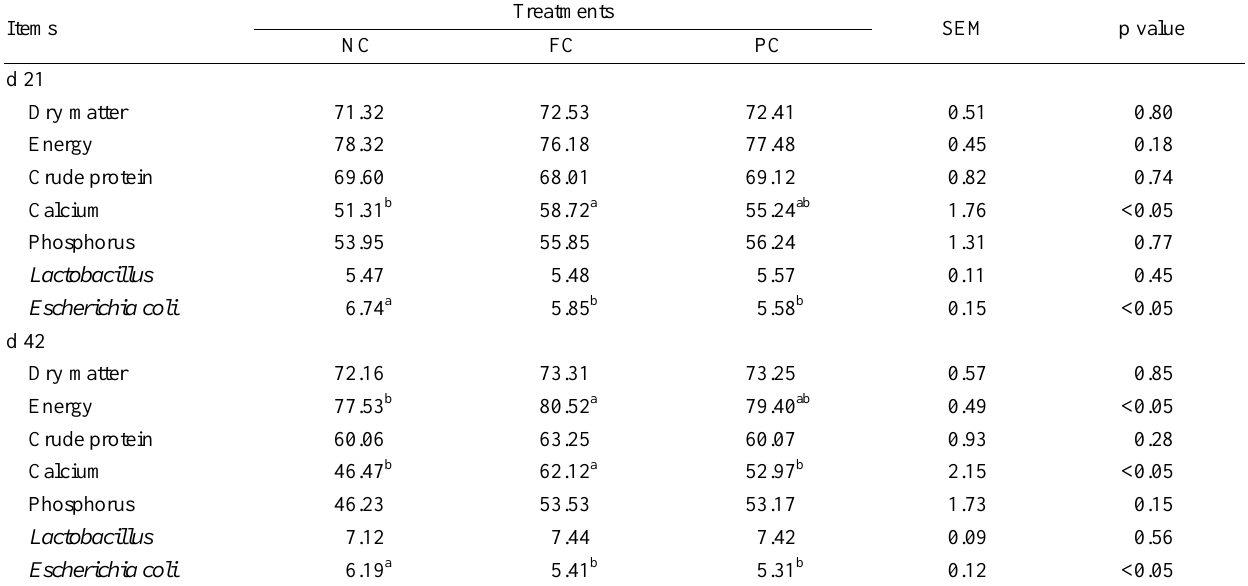
Table 4. Effects of dietary Forsythia suspensa extract (FSE) supplement on the apparent digestibility (%) of nutrients and bacterial concentrations (log CFU/g wet digesta) in broilers